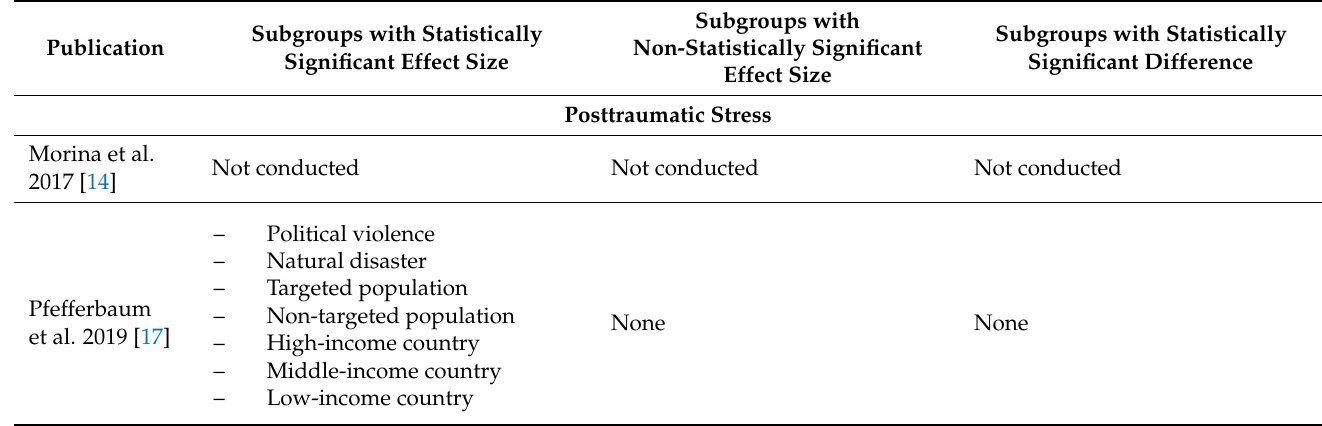
Table 2. Results of subgroup analyses conducted across the